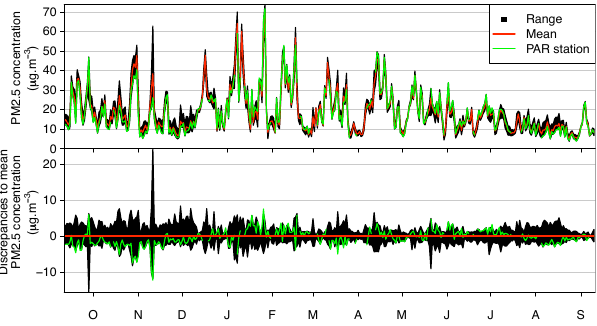
Figure 3. Daily PM 2 . 5 concentration range (black) from a set of four urban background stations in greater Paris (top panel), with mean daily (red) and PAR (green) concentration. Bottom panel: the same minus the mean PM 2 . 5